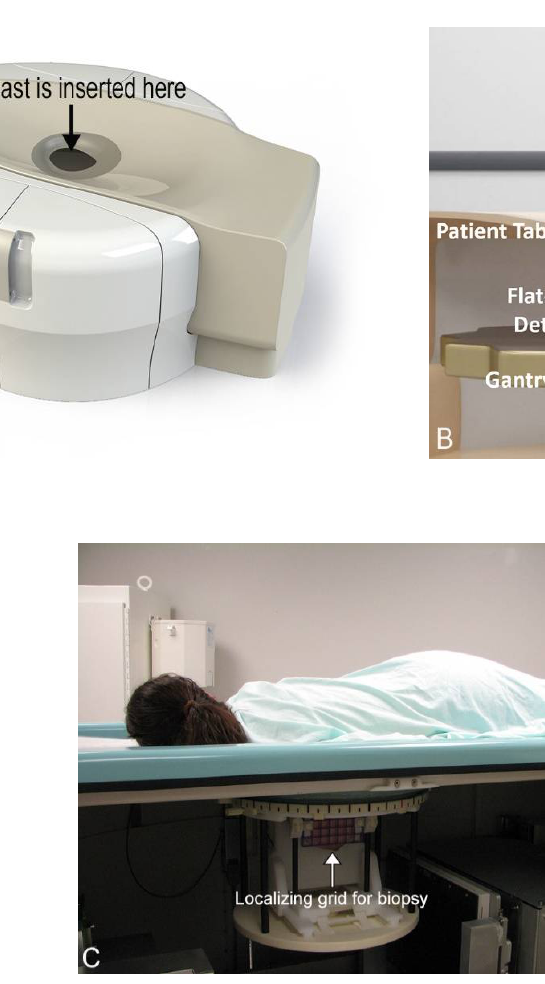
Figure 2. Cone-beam breast computed tomography (CBBCT) basics. ( A ) Picture of a CBBCT machine with the area that the patient inserts her breast labeled. ( B ) Labeled schematic of a CBBCT machine. The patient is positioned prone in the scanner and one breast is imaged at a time. ( C ) Photo of a patient in position for biopsy with localizing grid for biopsy labeled.